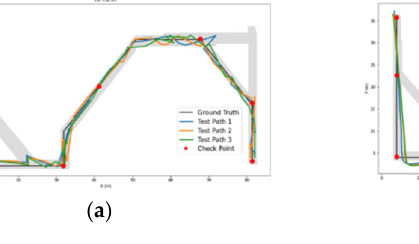
Table 5. Positioning error after coordinate constraint corrections (m). Min